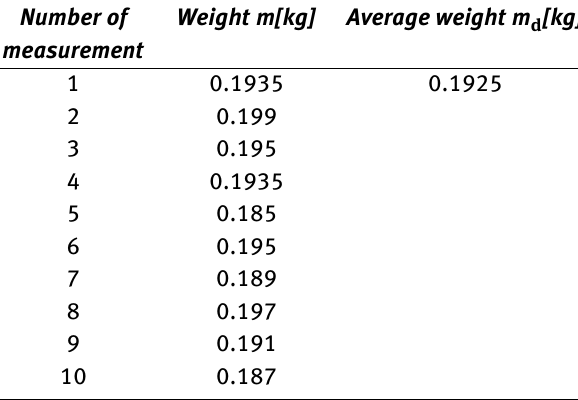
Table 2: Weight of the glass beads exerting pressure on the